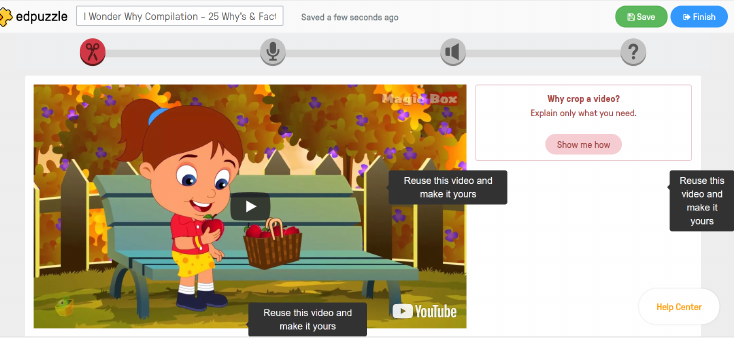
Fig. 1. Create an activity at EDPuzzle